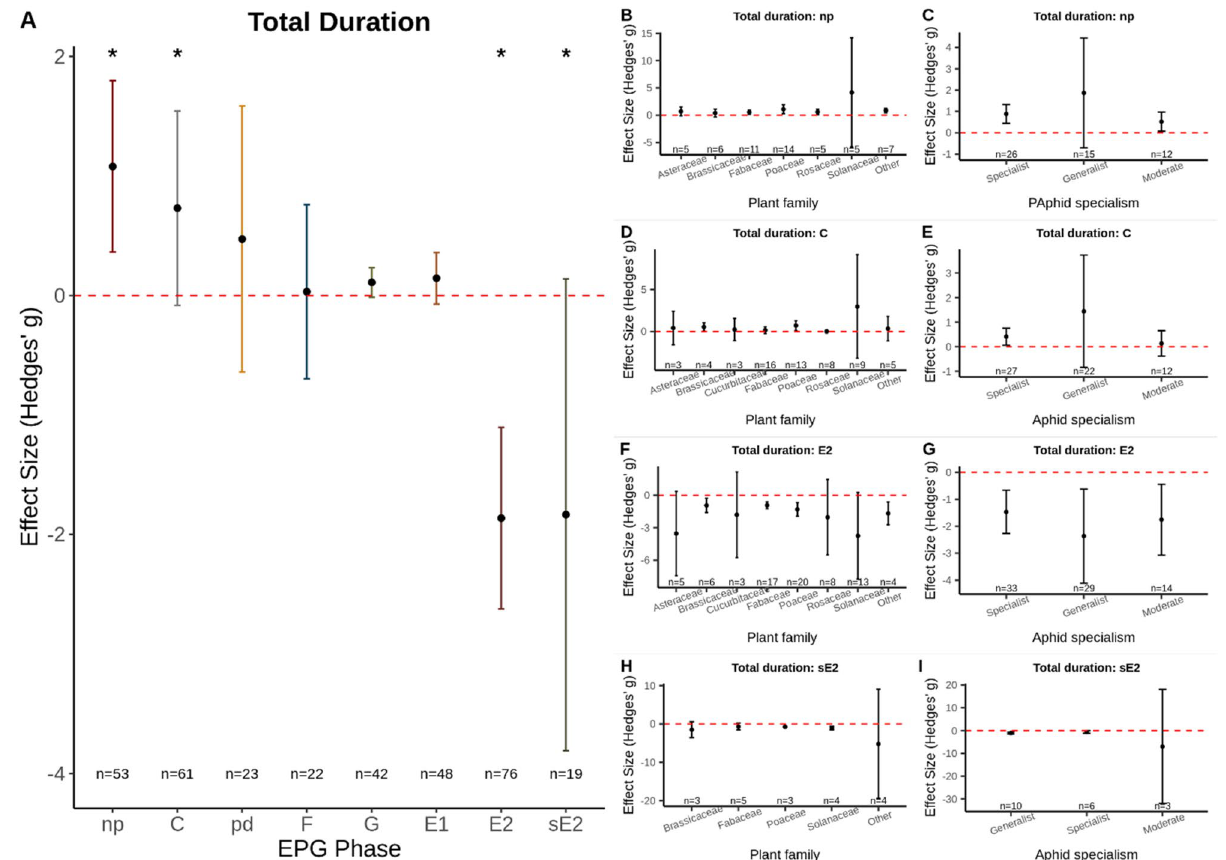
Figure 3. ( A ) The mean effect size for each EPG phase for the aphid “Duration” dataset; * indicates EPG phases significantly impacted by plant resistance. ( B – I ) sub-group analysis for the four EPG phases where the total duration was significantly different between aphids feeding on susceptible vs. resistant plants. Total duration of np ( B , C ), total duration of C ( D , E ), total duration of E2 ( F , G ), and total duration of sE2 ( H , I ). Sub-group analysis was done for plant family ( B , D , F , H ) and aphid specialism ( C , E , G , I ). Graphs displays the mean effect size (Hedges’ g) and the 95% confidence intervals. Red dashed line displays the zero effect